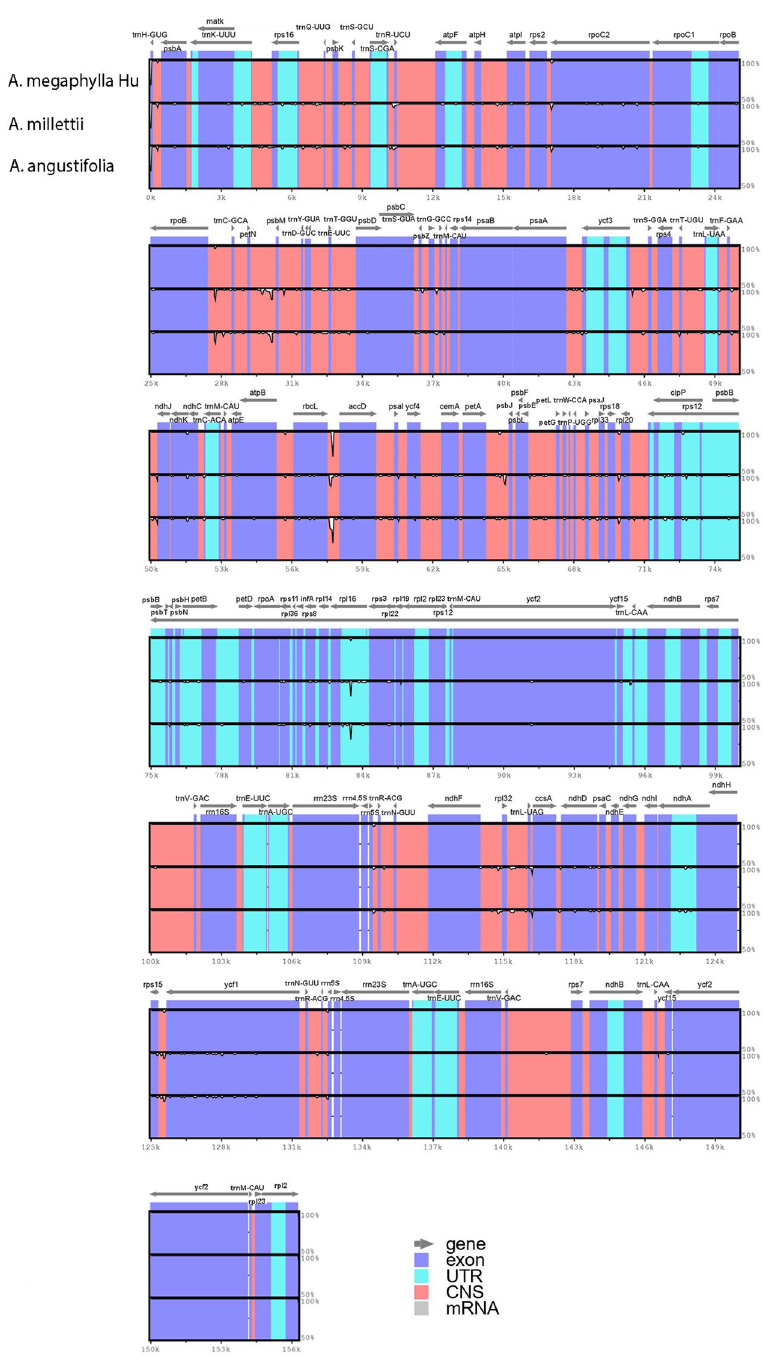
Figure 4. Identity plot comparing the chloroplast genomes of three Adinandra